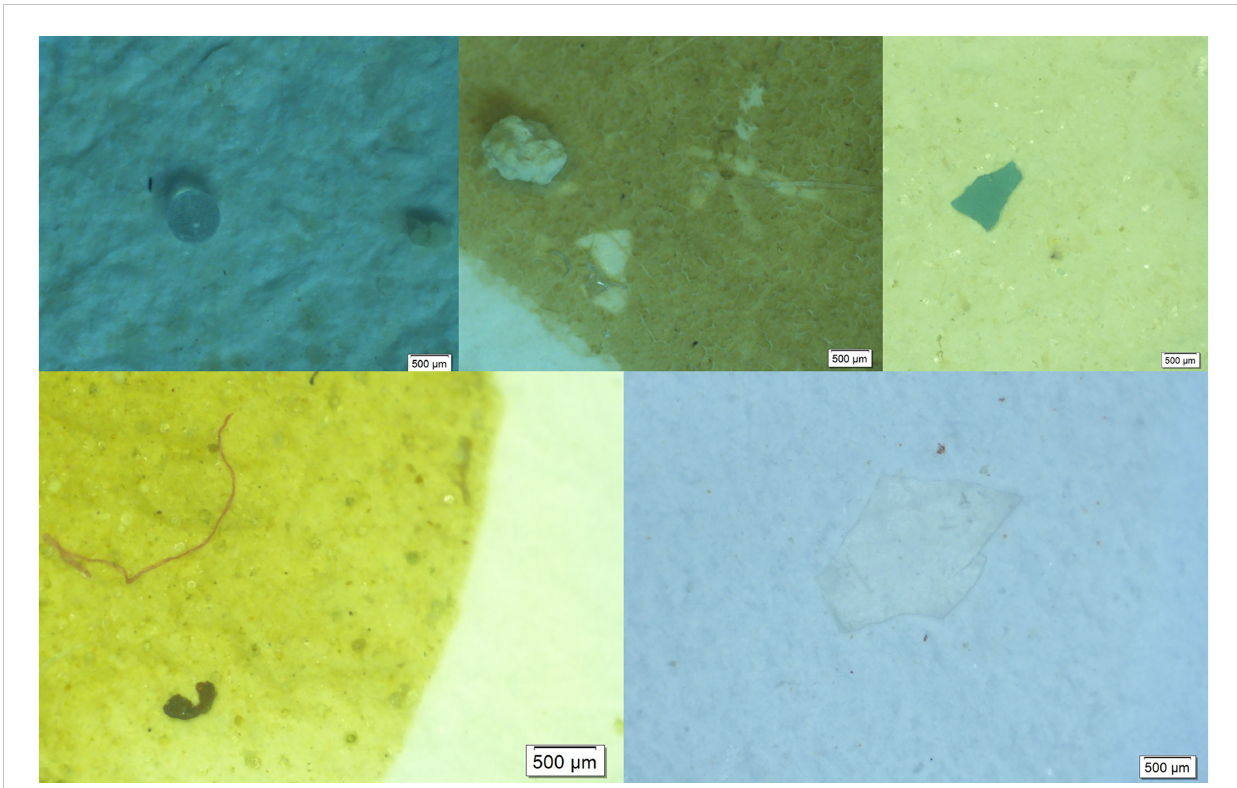
FIGURE 5 Image of recovered colourless pellet, white foam, green fragment, red and black fi bre, and transparent fi lm of this study